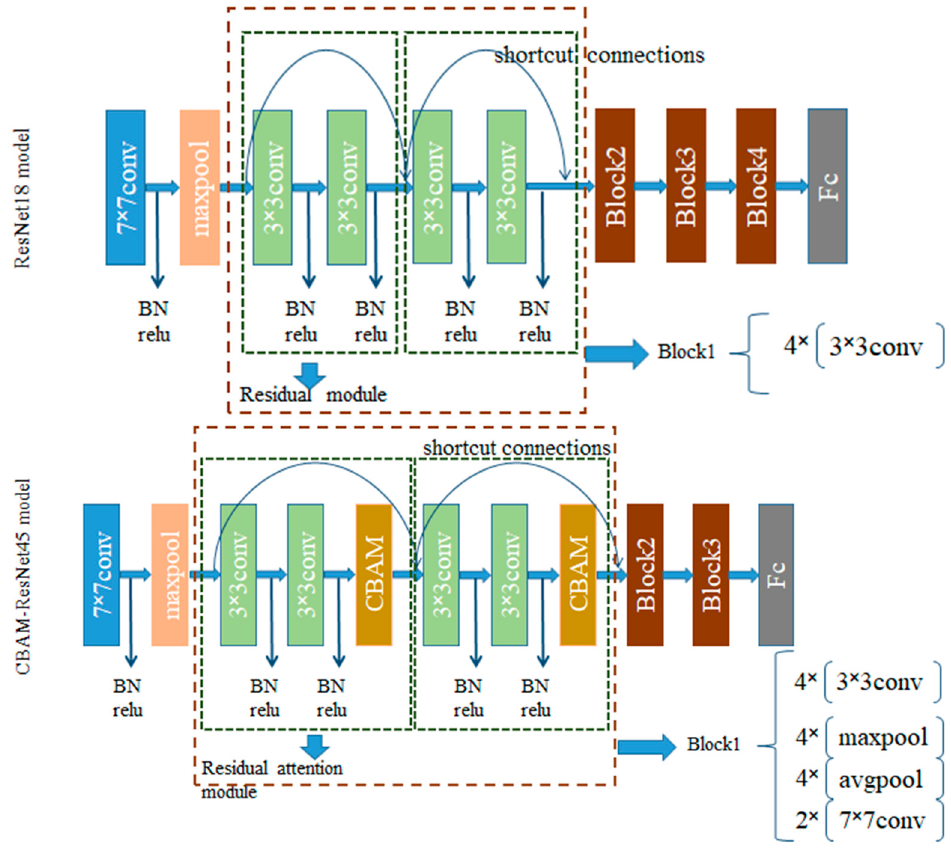
Figure 5. The framework of the ResNet18 model and the CBAM-ResNet45 model.